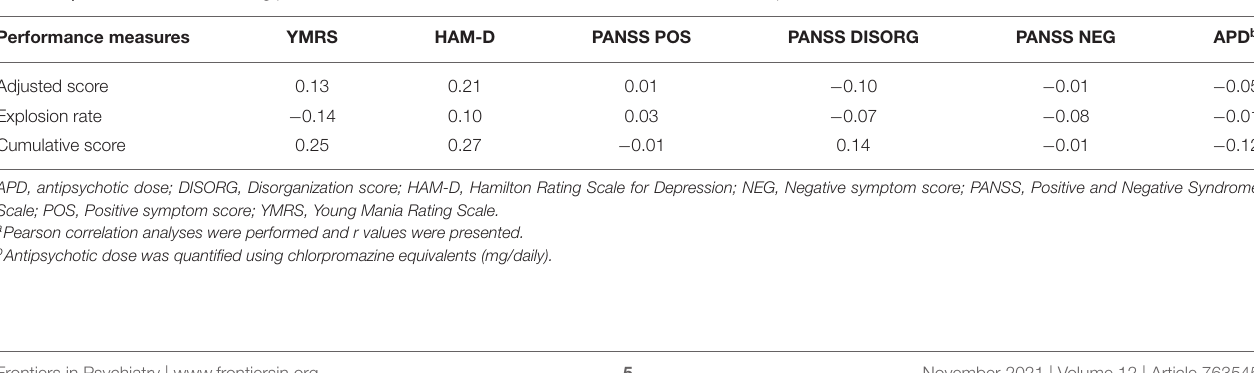
TABLE 3 | Correlations of risk-taking performance measures with clinical and treatment characteristic in patients a .